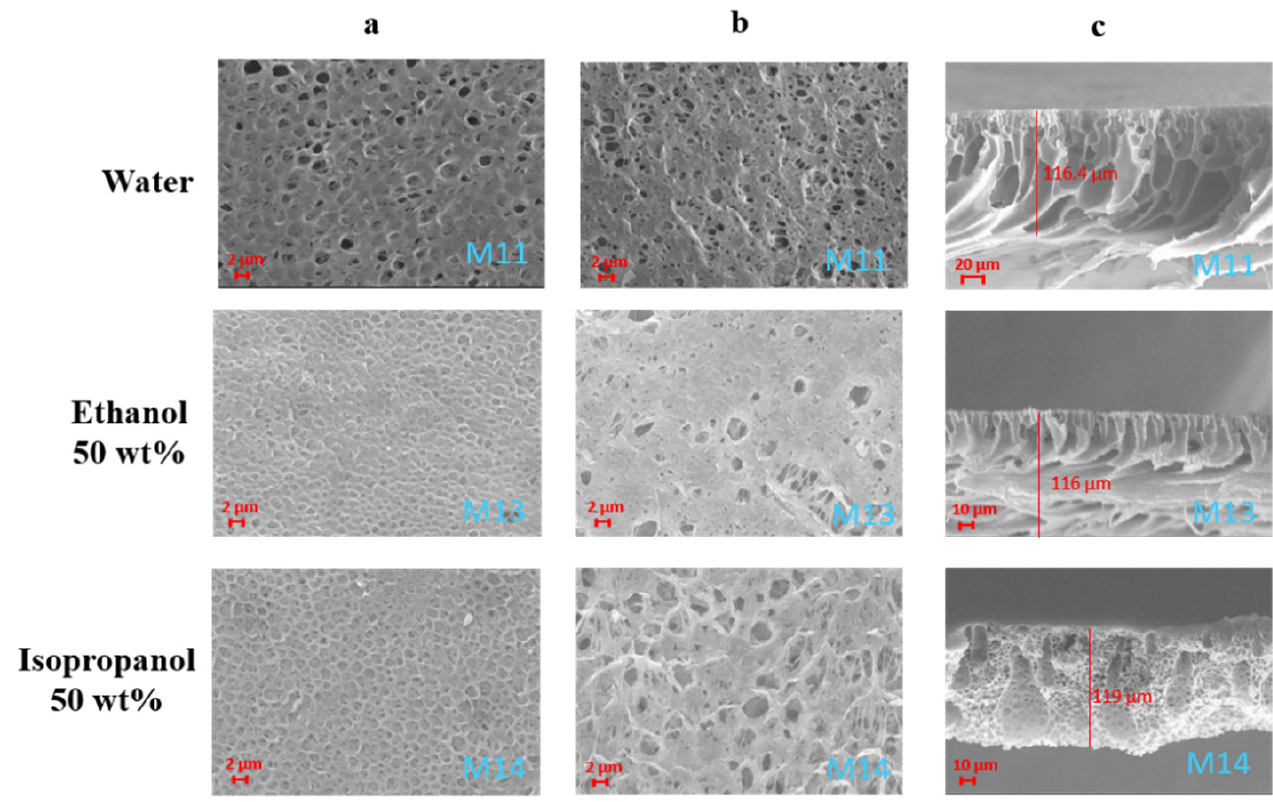
Figure 11. SEM images illustrating the effect of the coagulation bath composition on PVDF-HFP/S-PES/PolarClean membranes M11, M13 and M14: ( a ) top surfaces; ( b ) bottom surfaces; ( c ) cross-sec- tions.